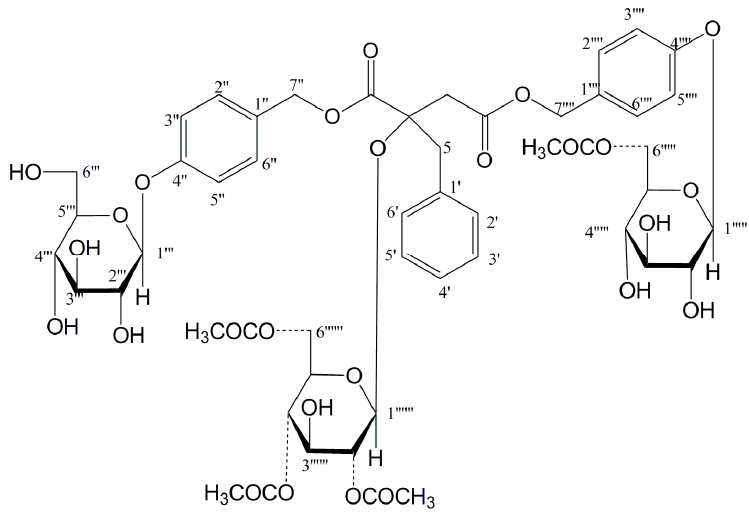
Figure 6. Proposed structure of A8